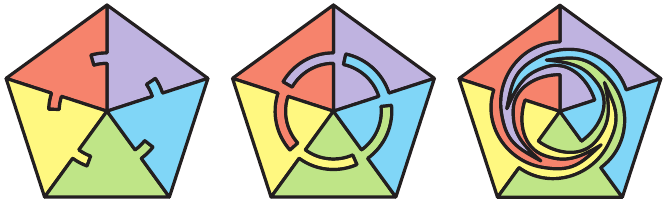
Figure 2. Interlocked polygons freed by removing any one, two, or three of the polygons (from left to